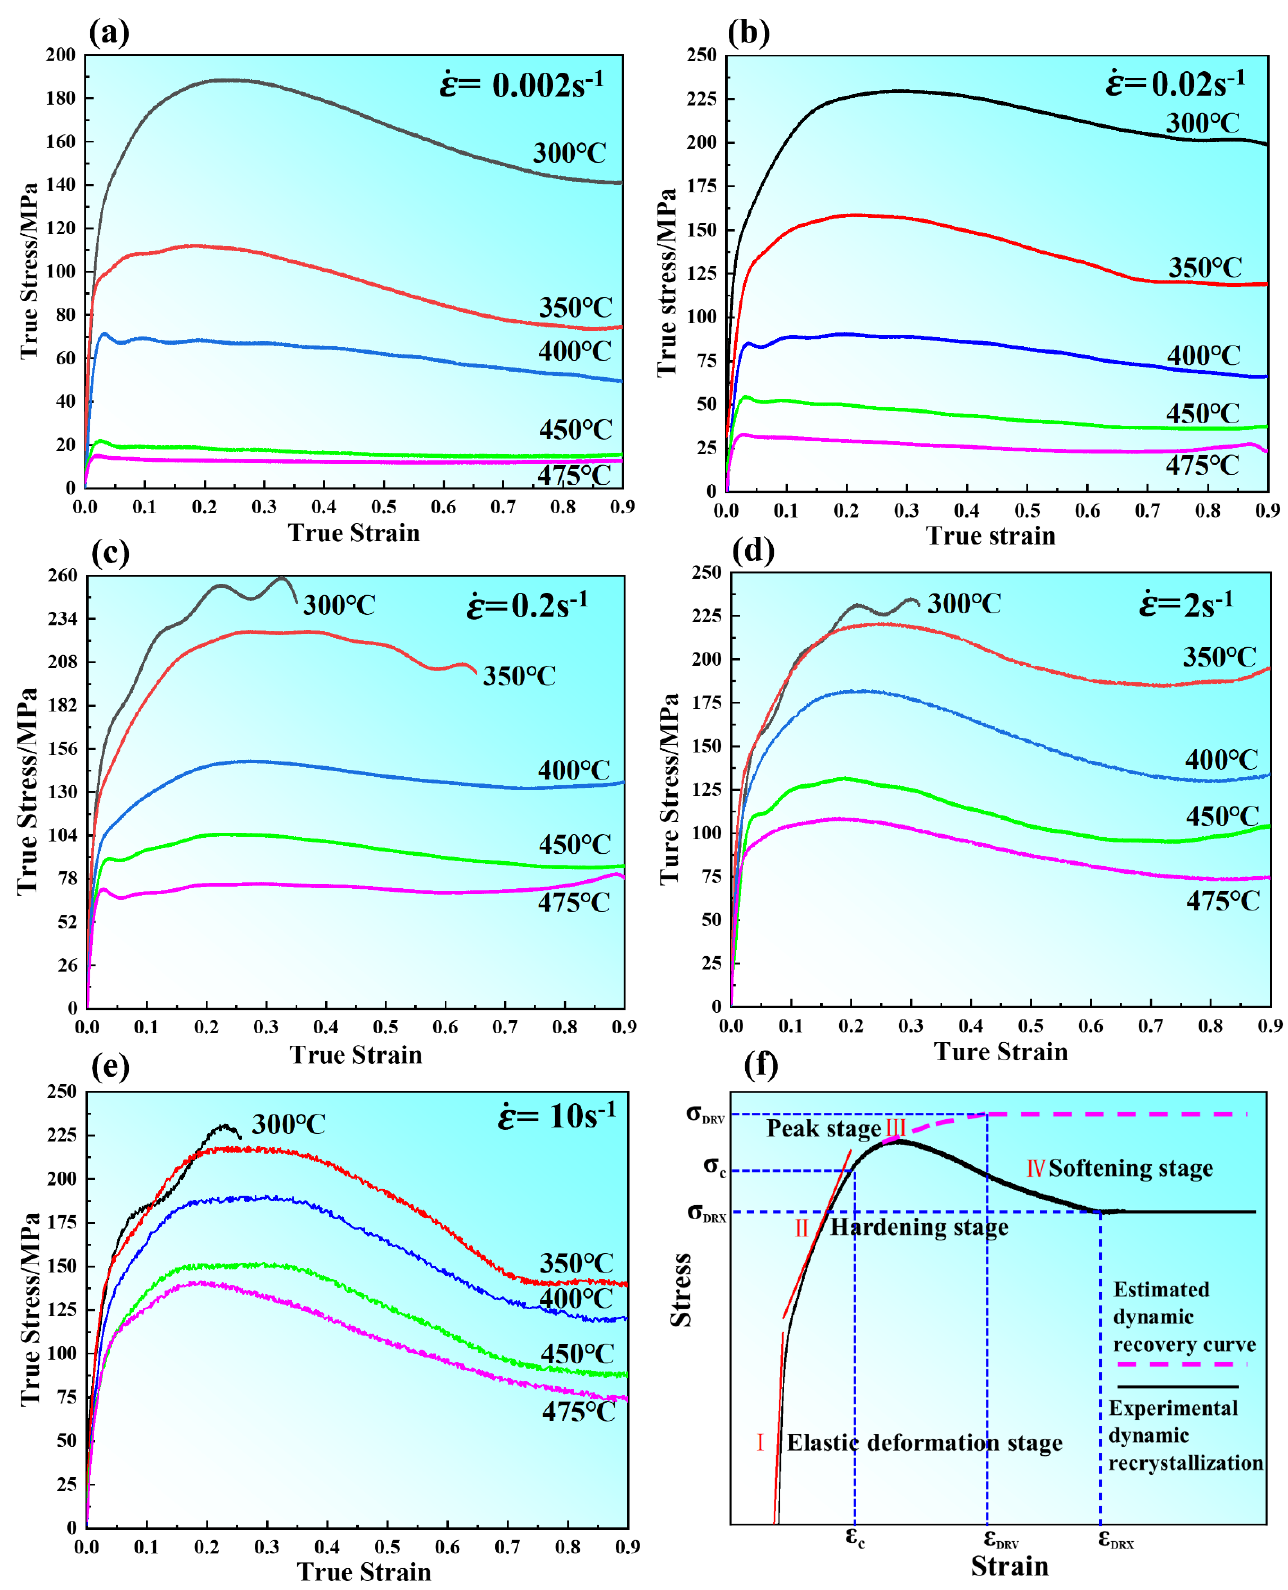
Figure 3. Flow stress curves of the as-solutioned GW94K alloy over the temperature range of 300~475 °C at strain rates of ( a ) 0.002 s −1 , ( b ) 0.02 s −1 , ( c ) 0.2 s −1 , ( d ) 2 s −1 , ( e ) 10 s −1 , ( f ) schematic presentation of the flow curves for dynamic recovery and dynamic recrystallization.